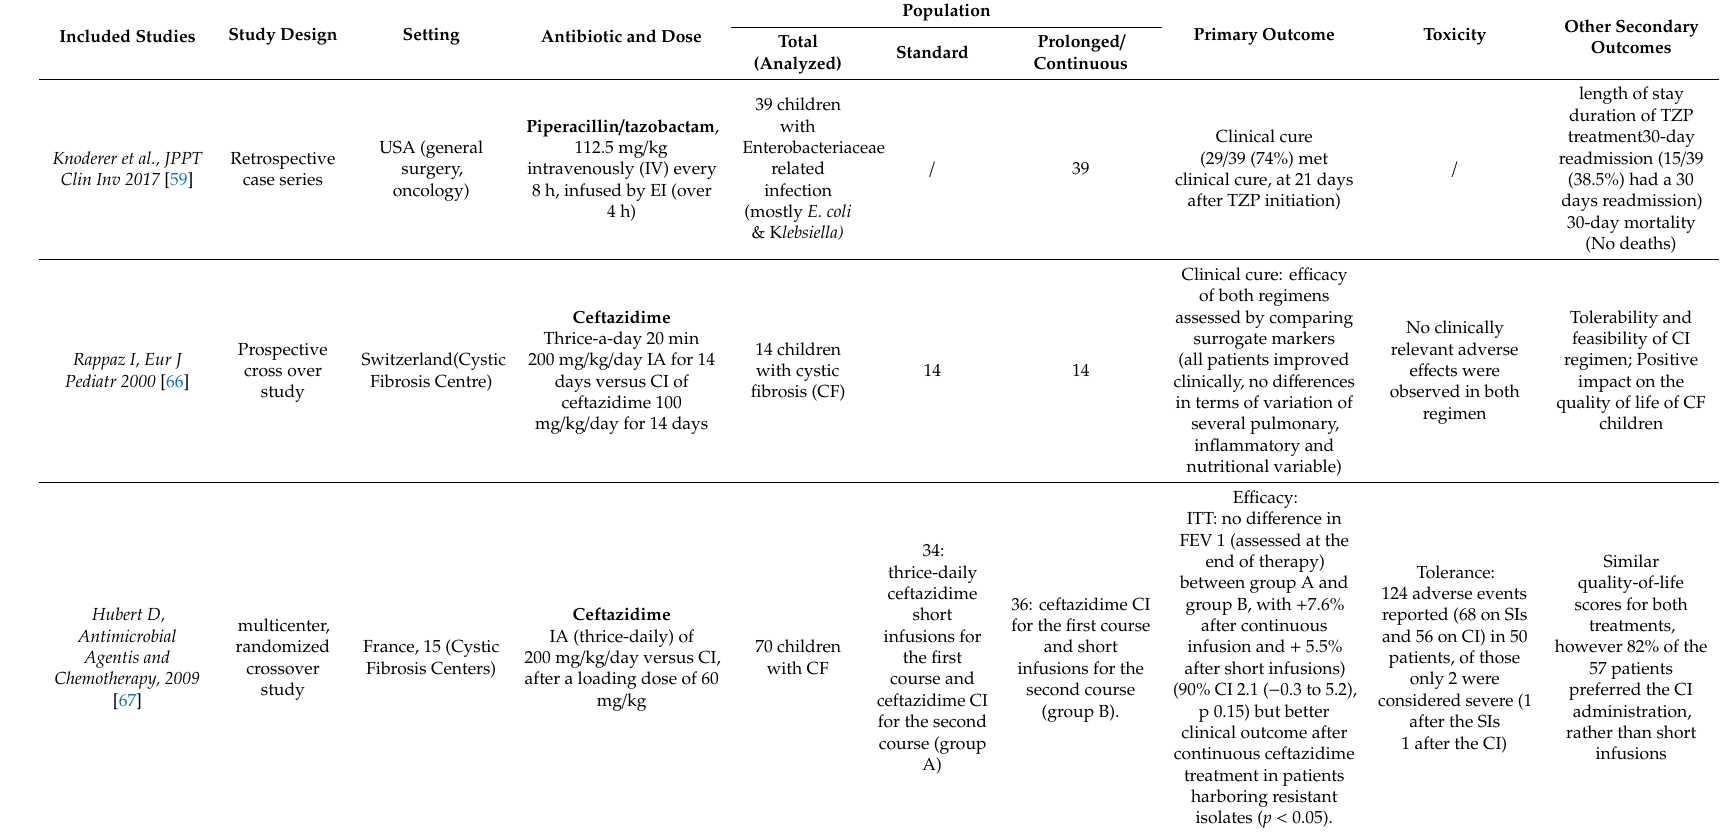
E ffi cacy: ITT: no di ff erence